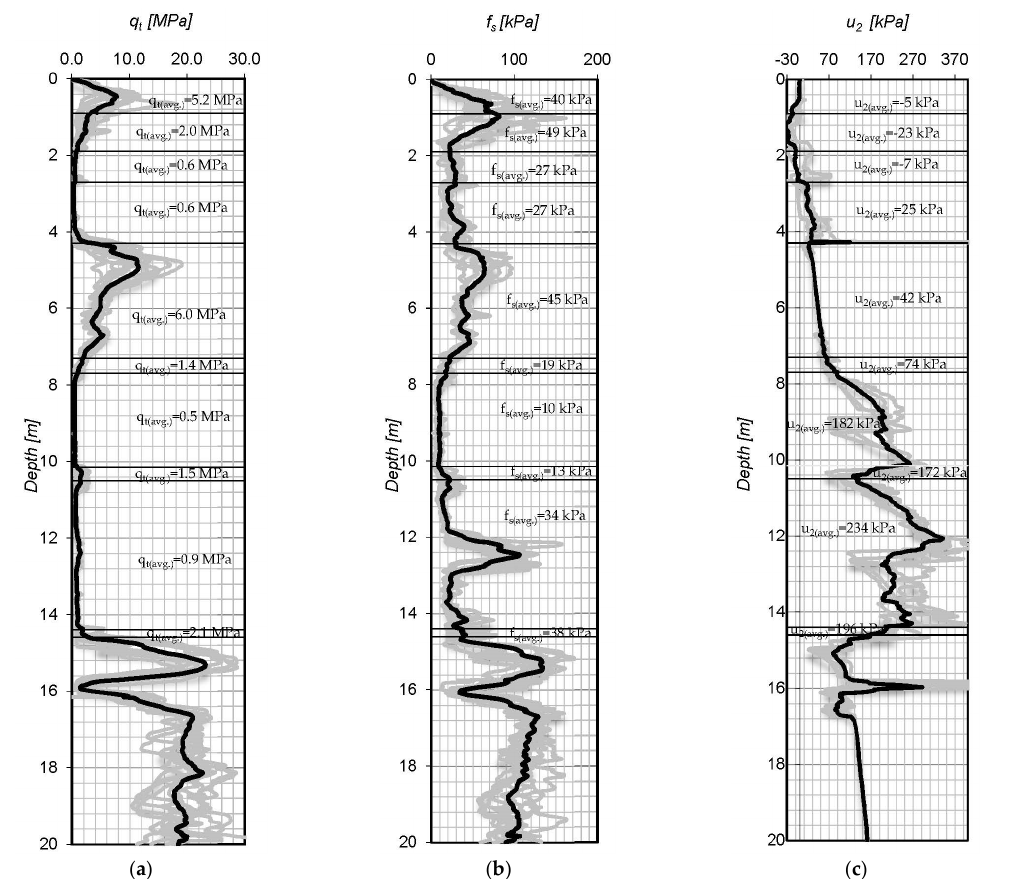
Figure 1. The CPTu measurement results of: ( a ) corrected cone resistance, ( b ) sleeve friction, ( c ) pore water pressure with average CPTu measurement value per soil layer.